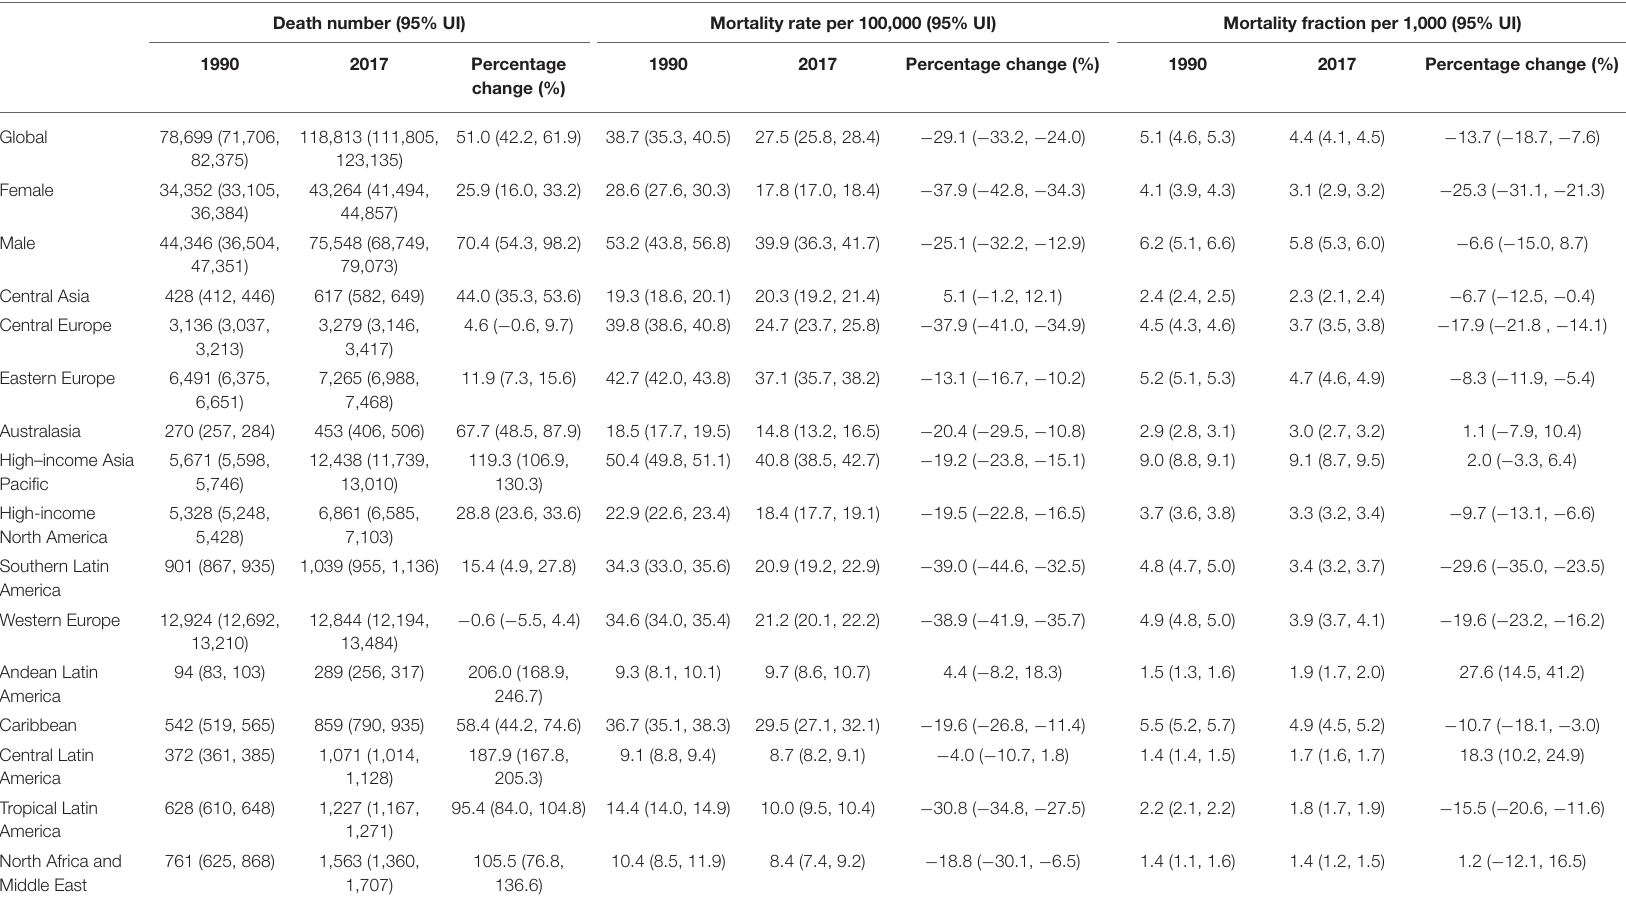
TABLE 1 | Death numbers, mortality rates, and mortality fractions from suicide for people aged 70 and older, and their percentage changes between 1990 and 2017, by sex and GBD region. Death number (95% UI) Mortality rate per 100,000 (95% UI) Mortality fraction per 1,000 (95%